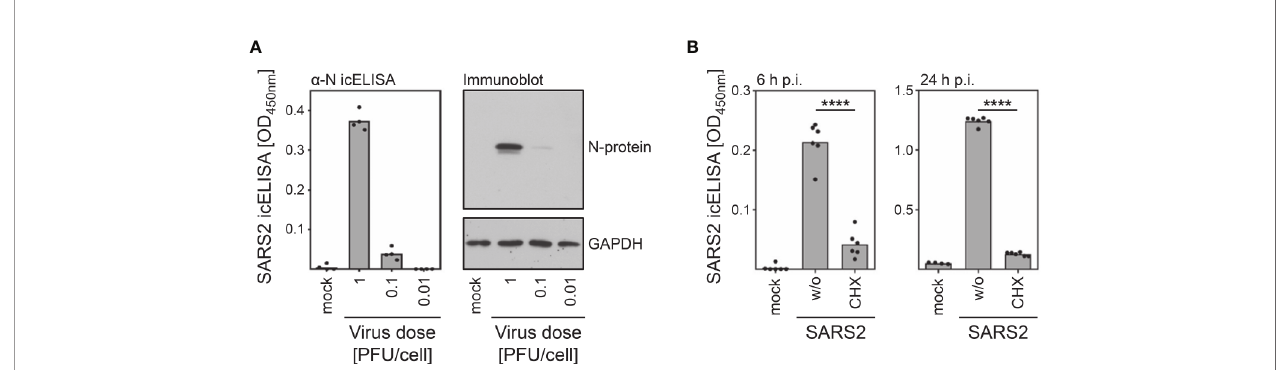
FIGURE 2 | The icELISA faithfully reports on SARS-CoV-2 N protein expression. (A) Vero E6 cells were infected with indicated doses of SARS-CoV-2. At 6 h p.i., cells were fi xed for icELISA analysis or lysed for immunoblot analysis. Bars depict icELISA mean values. Dots show values of individual measurements. Immunoblot analysis was performed using antibodies recognizing the N protein of SARS-CoV-2 or GAPDH. (B) Vero E6 cells were infected with SARS-CoV-2 (10,000 PFU per well) in the absence ( ‘ w/o ’ ) or presence of the translation inhibitor cycloheximide ( ‘ CHX ’ ). At 6 and 24 h p.i., cells were analyzed by icELISA. Bars depict mean values. Dots show values of individual measurements. Signi fi cance was calculated by unpaired two-tailed student´s t-test. ****p-value